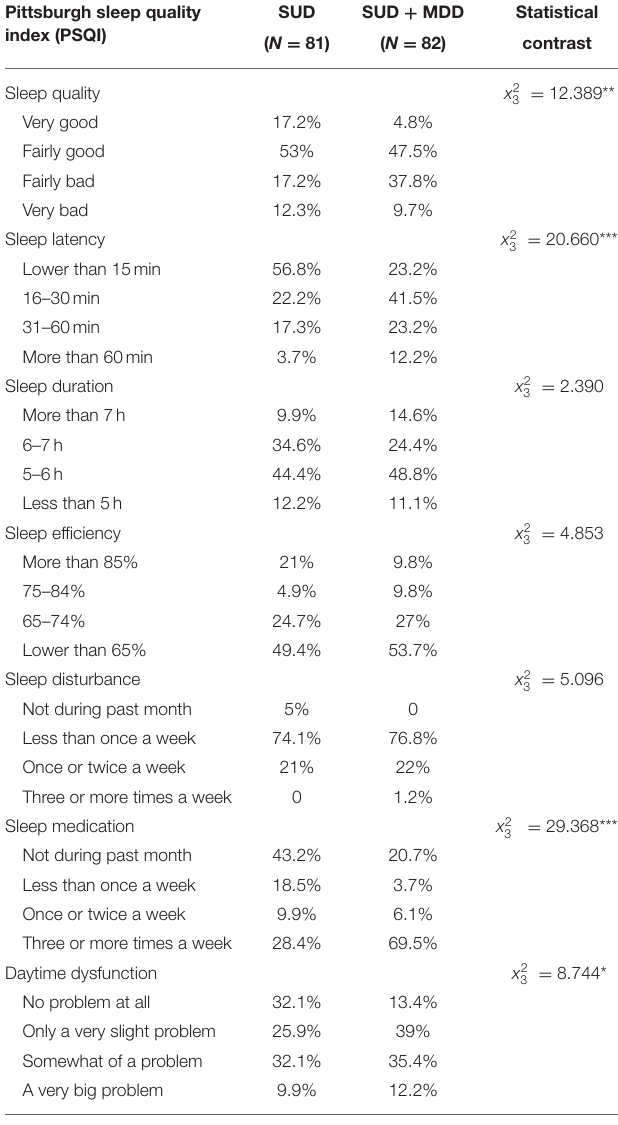
TABLE 5 | Quality and dimensions of sleep for the SUD and SUD + MDD patients. Pittsburgh sleep quality index